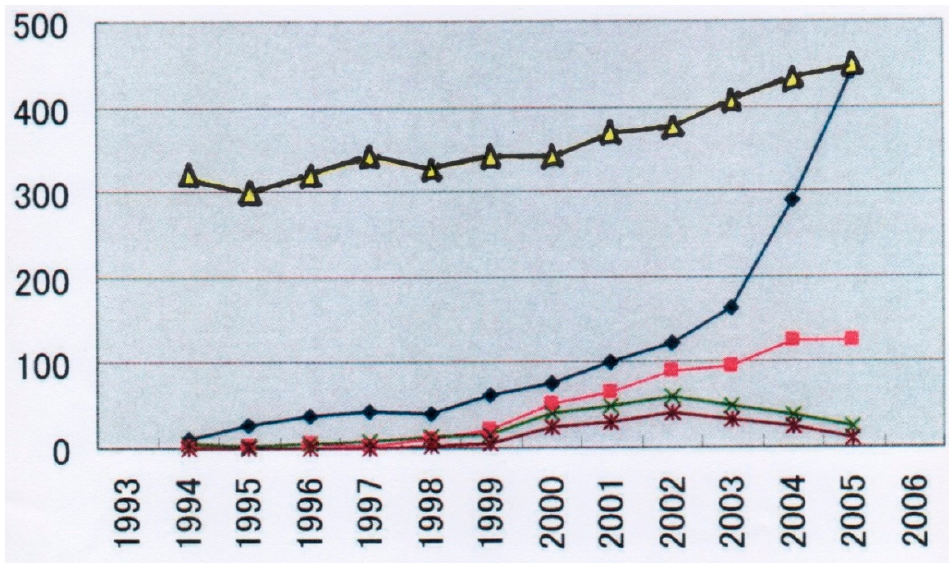
Figure 7. Patent applications by Toyota and Panasonic. Source: Hayashi, M (2008) [19].